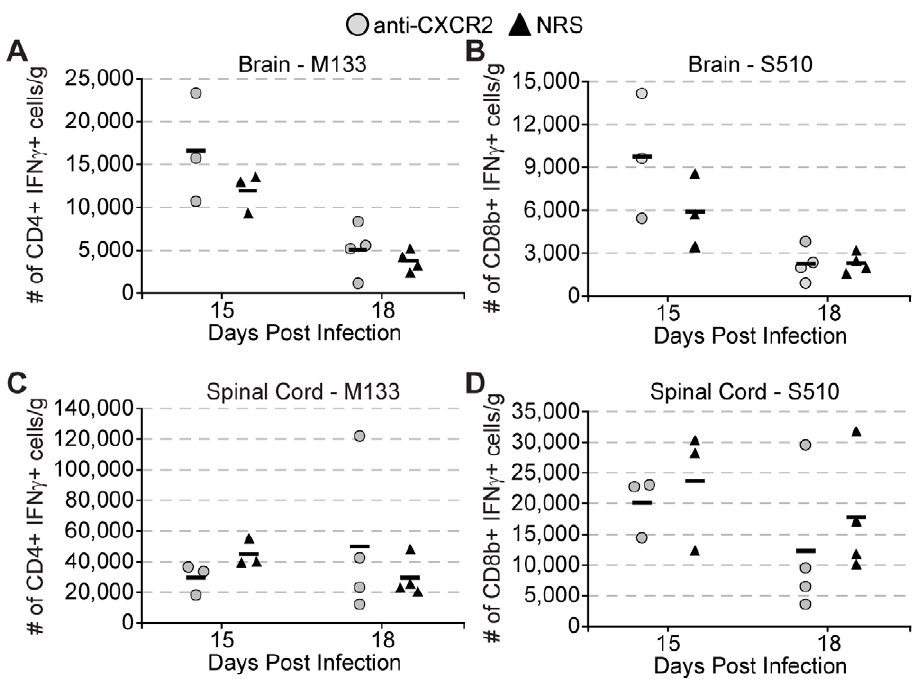
Figure 4. CXCR2 neutralization does not diminish virus – specific T cell infiltration during chronic JHMV infection. C57BL/6 mice were i.c. infected with 500 pfu JHMV and treated with neutralizing CXCR2 antiserum or control normal rabbit serum (NRS) i.p. from day 12 to 18. Brains ( A & B ) and spinal cords ( C & D ) were removed at defined times p.i. and isolated cells were stimulated ex vivo for six hours with 5 m M of the immunodominant CD4 + epitope M 133–147 ( A & C ) or 5 m M of the immunodominant CD8 + epitope S 510–518 ( B & D ) before intracellular IFN c staining was assessed. Data is representative of two independent experiments.